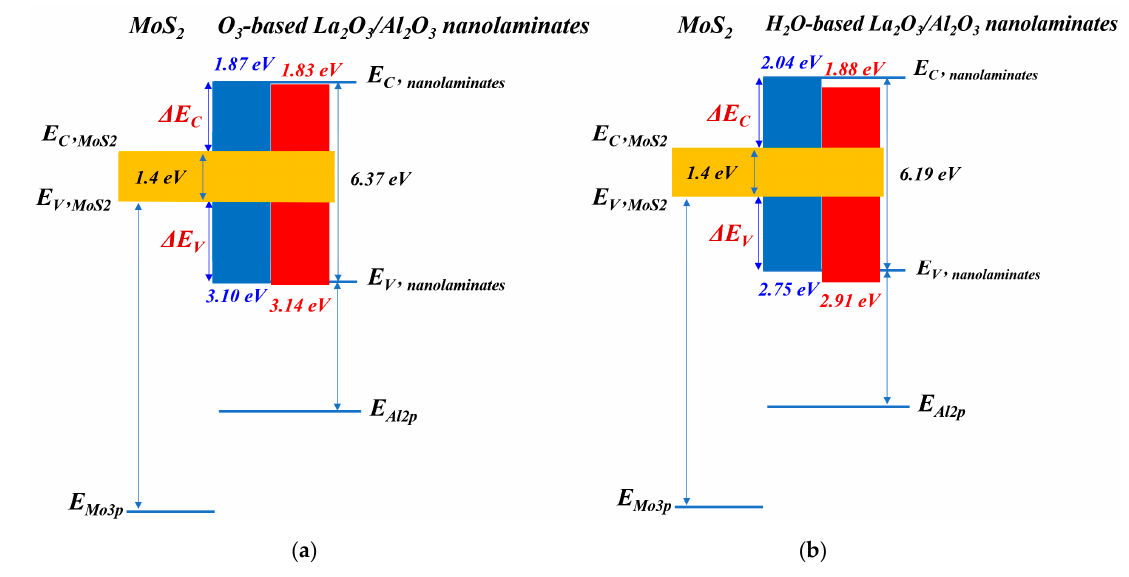
Figure 9. Band diagrams of ( a ) O 3 -based La 2 O 3 /Al 2 O 3 nanolaminates and ( b ) H 2 O-based La 2 O 3 /Al 2 O 3 nanolaminates on MoS 2 (Blue for MoS 2 and red for MoS 2 treated with UV-O 3 treatment).